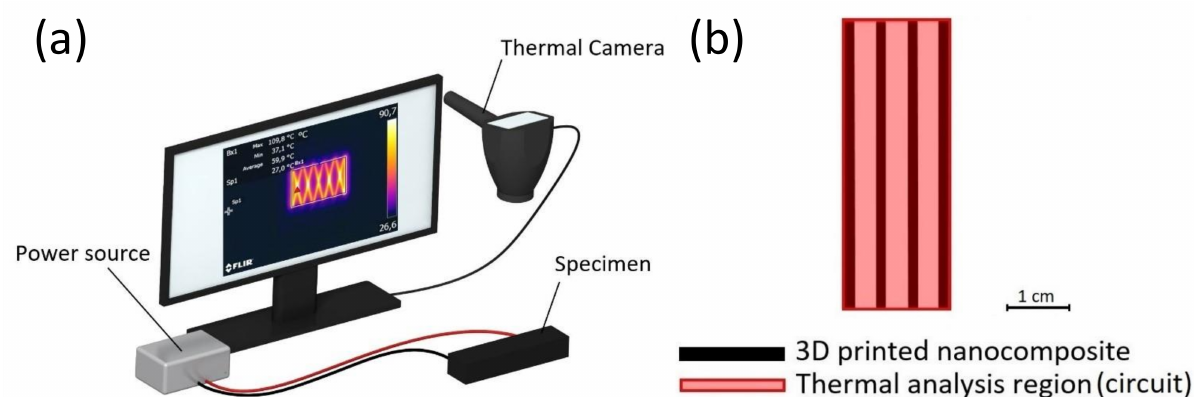
Figure 4. Self-heating tests. ( a ) Scheme of Joule’s heating tests where a thermal camera is pointing to the specimen when heating by applying 200 V with the power source and ( b ) region of thermal analysis used with FLIR Tools+